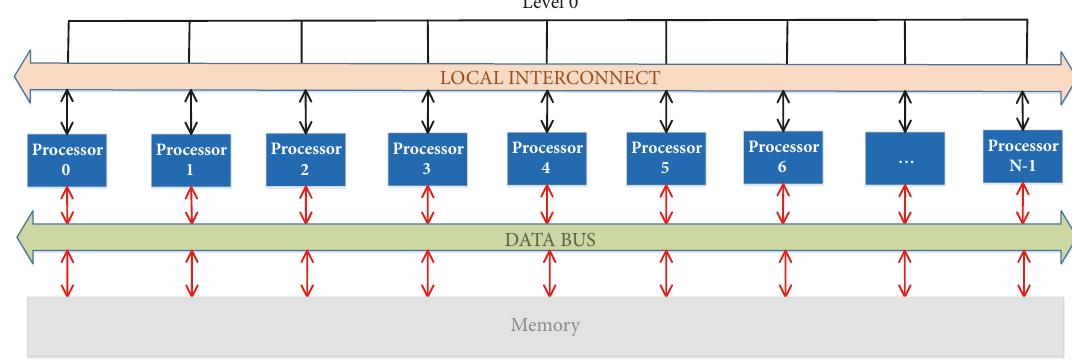
Figure 1: Parallel Random Access